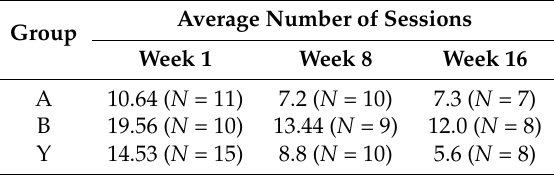
Table 4. Average number of sessions for each group for the participants still active in week 1, week 8 and week